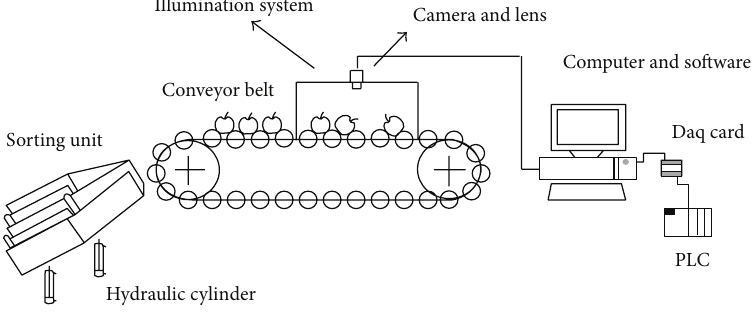
Figure 1: Schematic representation of machine vision system.